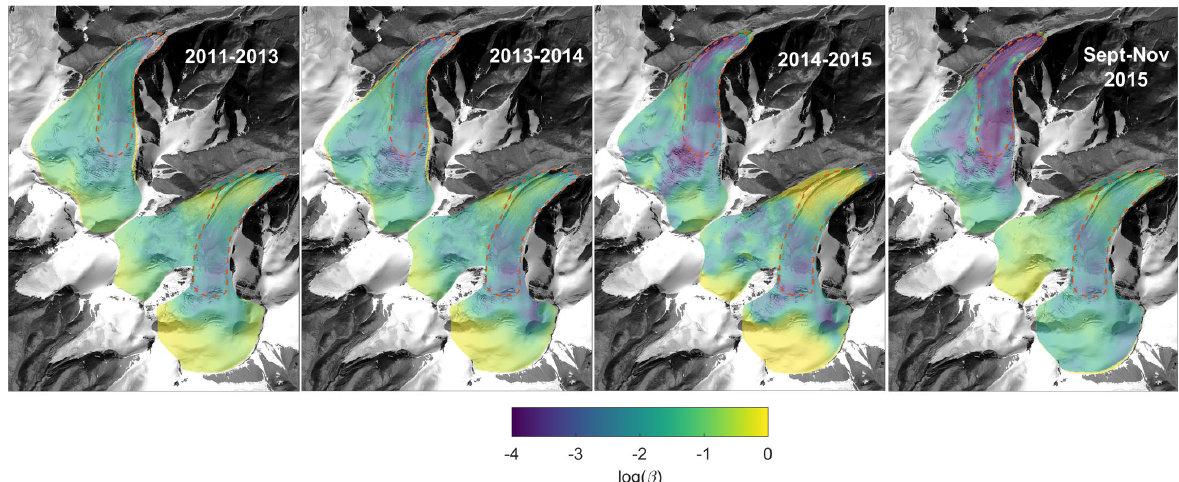
Figure 6. Friction coefficient β inferred from emergence velocity during different periods prior to the collapse. Orange dashed lines indicate the detachment